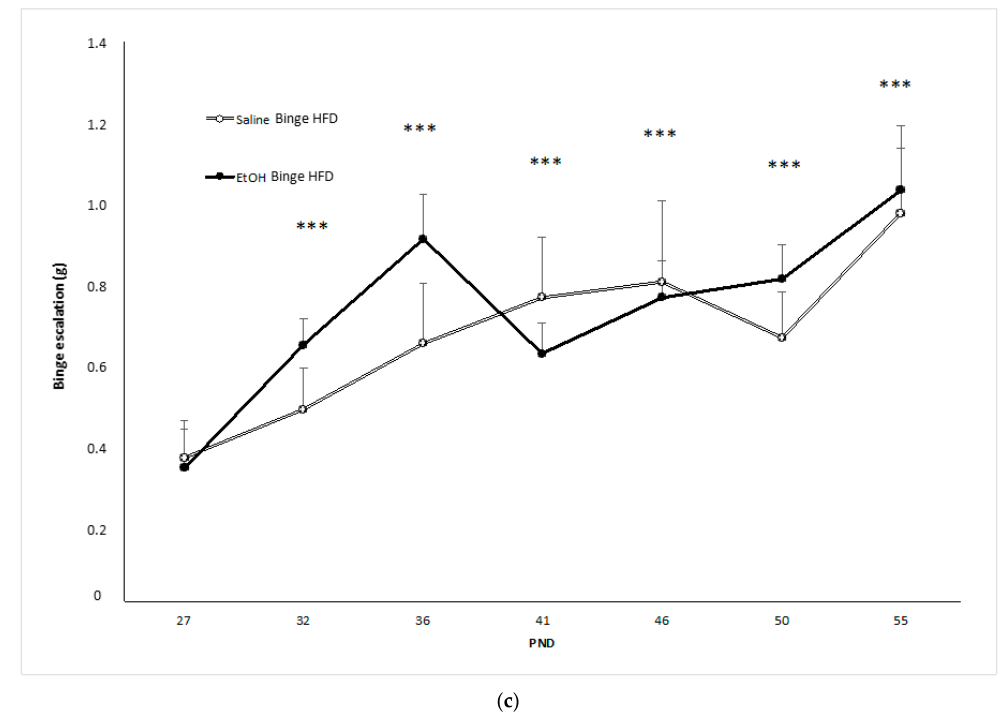
Figure 2. Body weight (BW), daily consumed kcal, and binge intake. ( a ) BW during the whole procedure. ( b ) Daily caloric intake (kcal). ( c ) Mean of binge high-fat diet (HFD) escalation during the procedure.